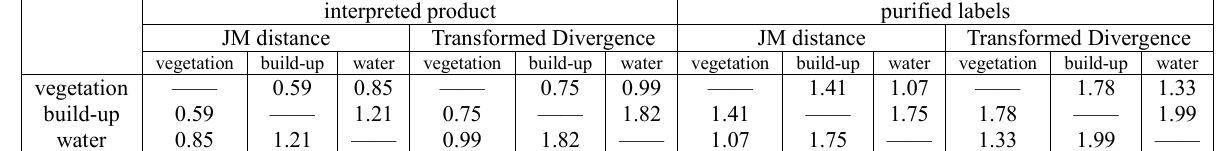
Table 5. The inter-class separability for Region